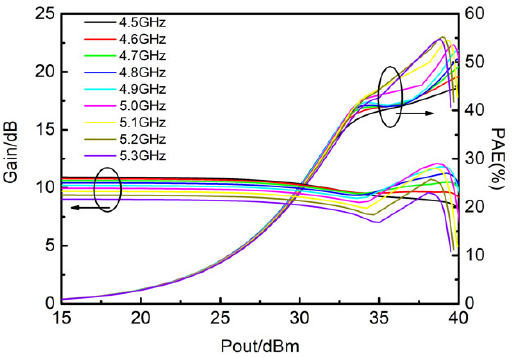
Figure 12. Simulated PAE and power gain of DPA under continuous wave (CW) simulation.